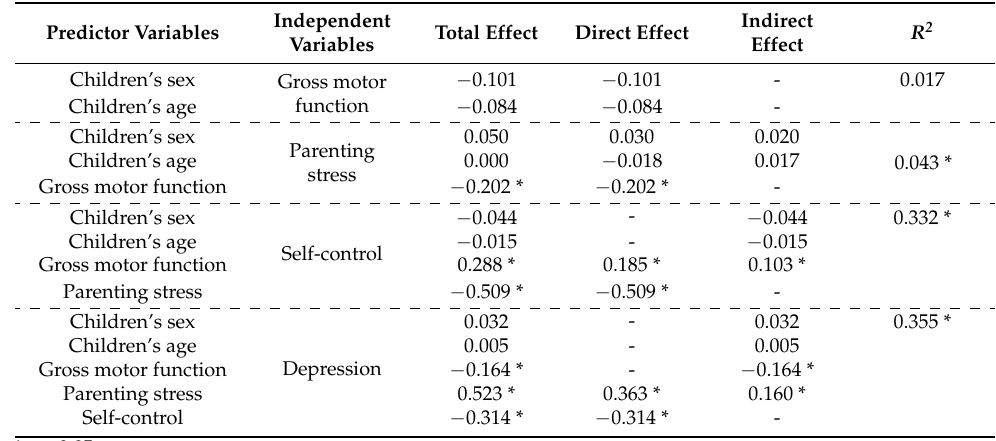
Table 5. Total, direct, and indirect effects of